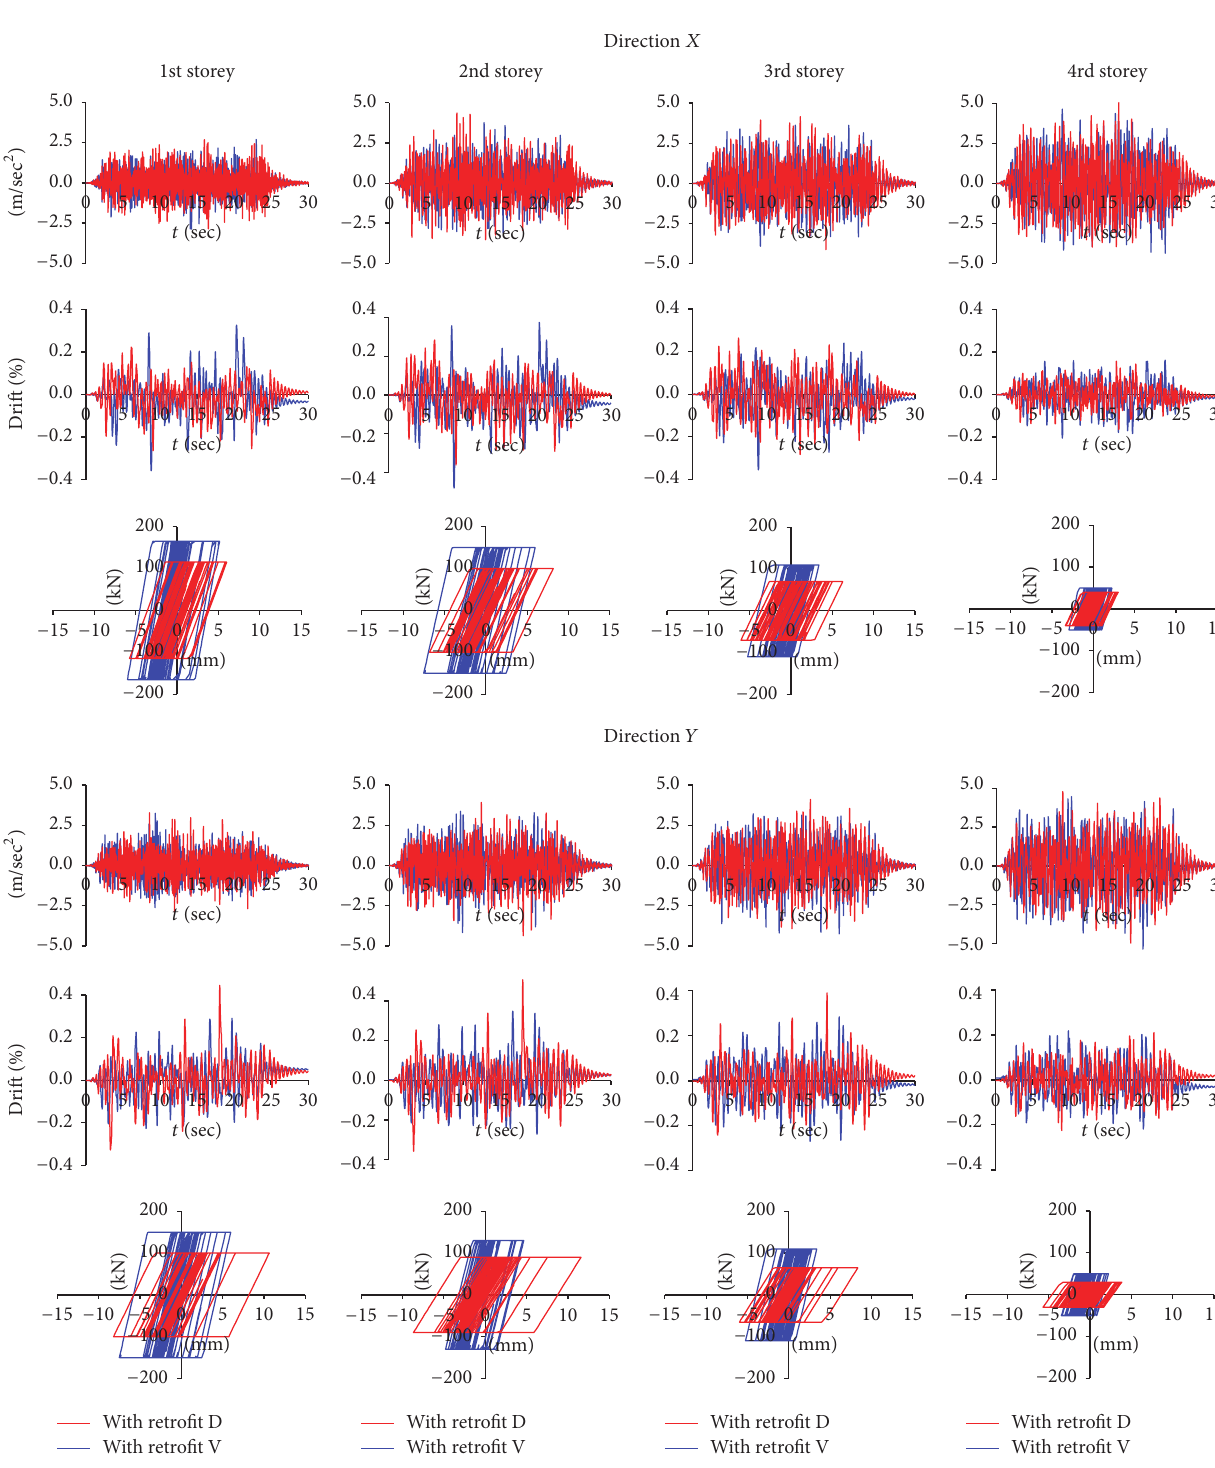
Figure 6: Comparison of NLDA results considering earthquakes number 1 and number 8 for both directions of drift, acceleration, and force-displacement of the elastoplastic braces on both configurations of EDB (D and inverted